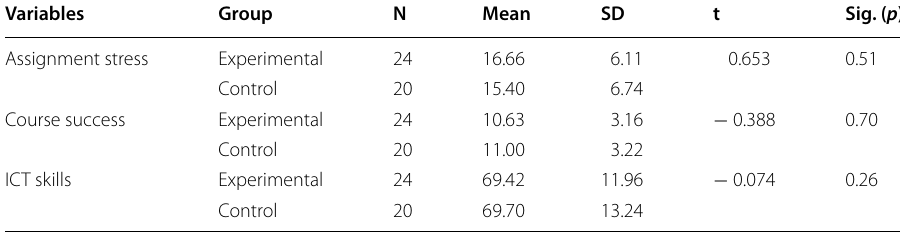
Table 1 t-test comparisons before the